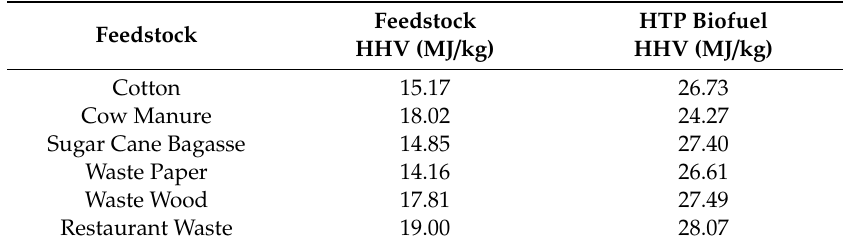
Table 2. Energy density for various feedstocks. Process time was 130 min and the temperature was 230 °C. The catalyst concentration was 2 g/L.